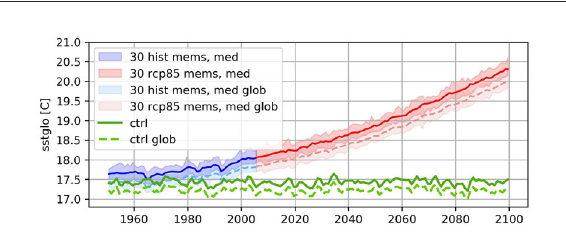
FIGURE2 Ensemble range and median of global mean SST of our 30 MPIOM-REMO (solid, “med”) and MPI-ESM1.1-LR (dashed, “med glob”) ensemble simulations. Green lines: PI control simulation